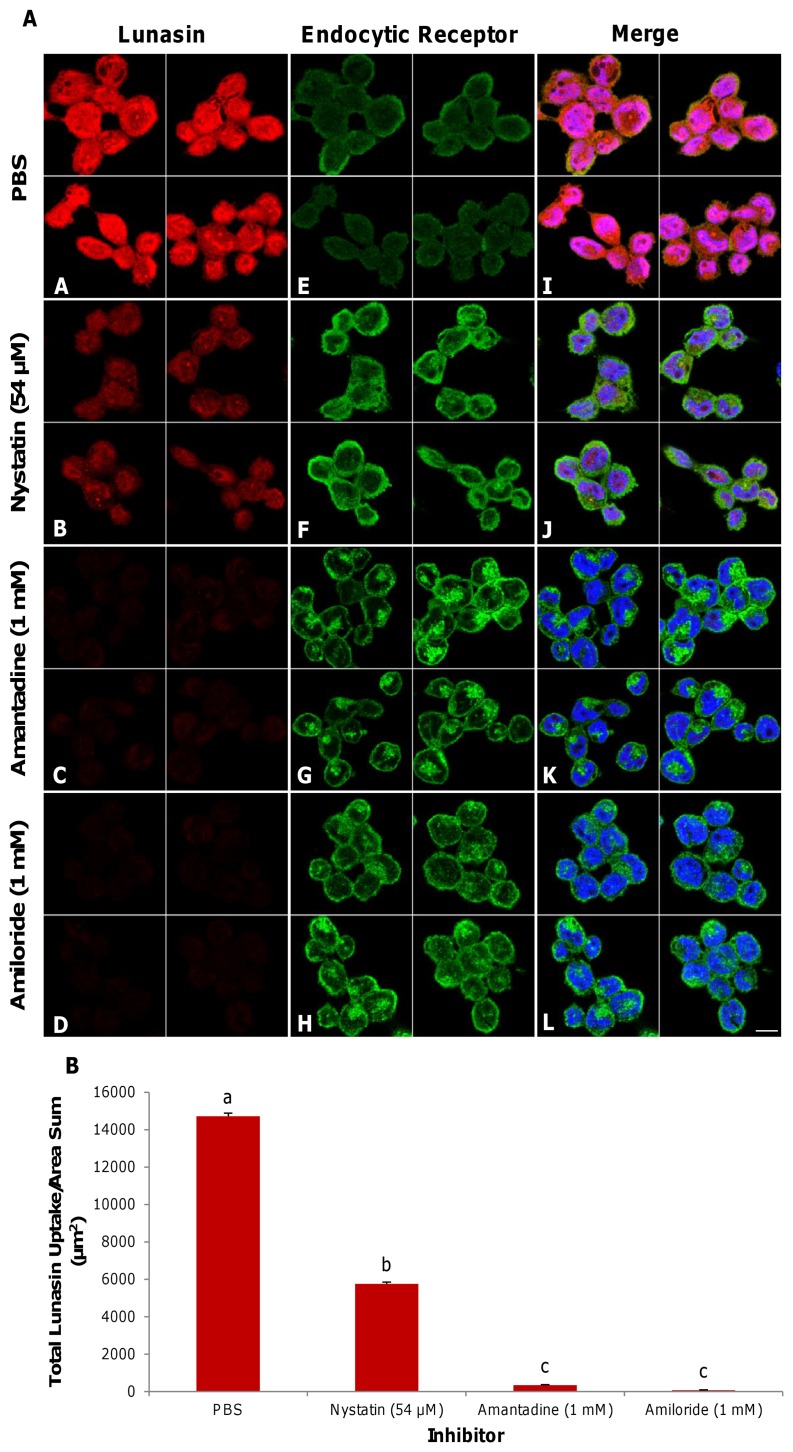
Lunasin internalization is primarily facilitated through clathrin-coated structures and macropinosomes.Two-dimensional immunocytochemical planes show lunasin (red), αVβ3 integrin, caveolin-1 or clathrin (green) and nuclei (blue) (
Figure 6A
). Macrophages were pretreated for 3 min with their respective endocytic inhibitors. Expression of αVβ3 integrin, caveolin-1 or clathrin (E–H) after treatment with lunasin and their specific inhibitors, respectively. Compared to the control (A, I), pretreatment with nystatin (54 µM, caveolae-mediated endocytic inhibitor) reduced lunasin internalization (B, J), while treatment with amantadine (1 mM, clathrin-mediated endocytic inhibitor) and amiloride (1 mM, macropinocytosis inhibitor) abolished lunasin uptake by macrophages (C, J and D, L). The effect of inhibitors on the endocytosis of lunasin (
Figure 6B
). In Figure 6B, the data represent the average of triplicates or quadruplicates ± SE. Four independent fields of view from three independent replicates of cells were merged together per treatment group. Means with different letters are significantly different from each other (n = 3, p<0.05). Bar  = 10 µm.